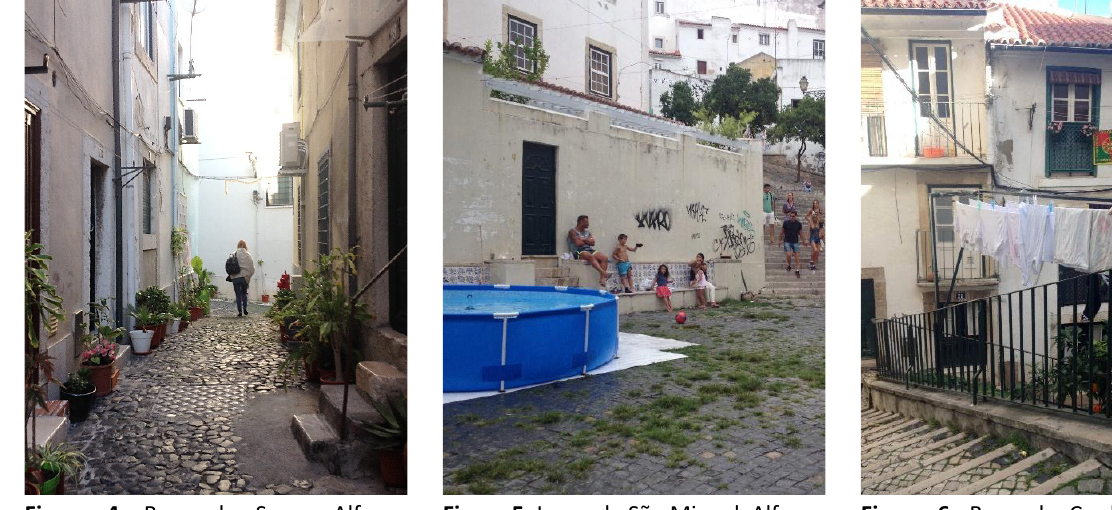
Figure 4. Beco do Surra, Alfama, Figure 5. Largo de São Miguel, Alfama, Figure 6. Beco da Cardosa, August 2018.